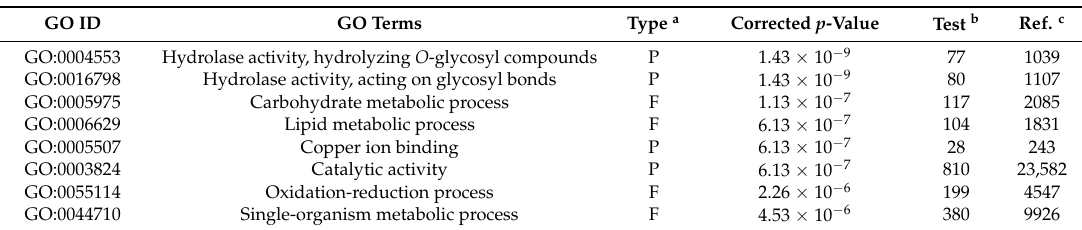
Table 2. Eight statistically enriched gene ontology (GO) terms of DEGs between normal temperature (NT) and moderately high temperature (MHT) exposed tobacco